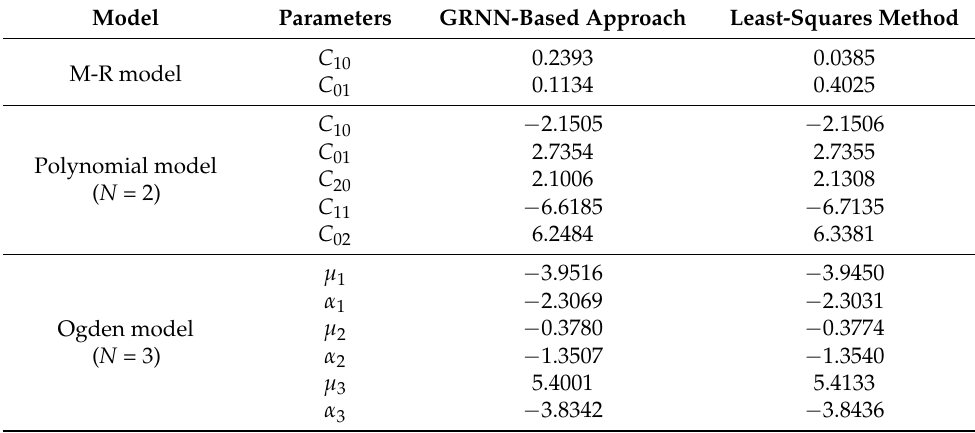
Table 2. Parameters obtained by GRNN-based approach and least-squares